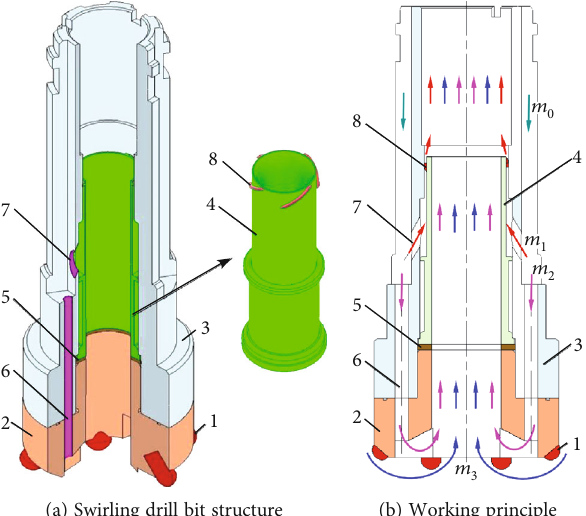
Figure 3: Swirling drill bit. 1: carbide inserts; 2: lower drill bit body; 3: upper drill bit body; 4: swirler; 5: sealing; 6: fl ushing nozzles; 7: inner suction nozzles; 8: spiral blade.